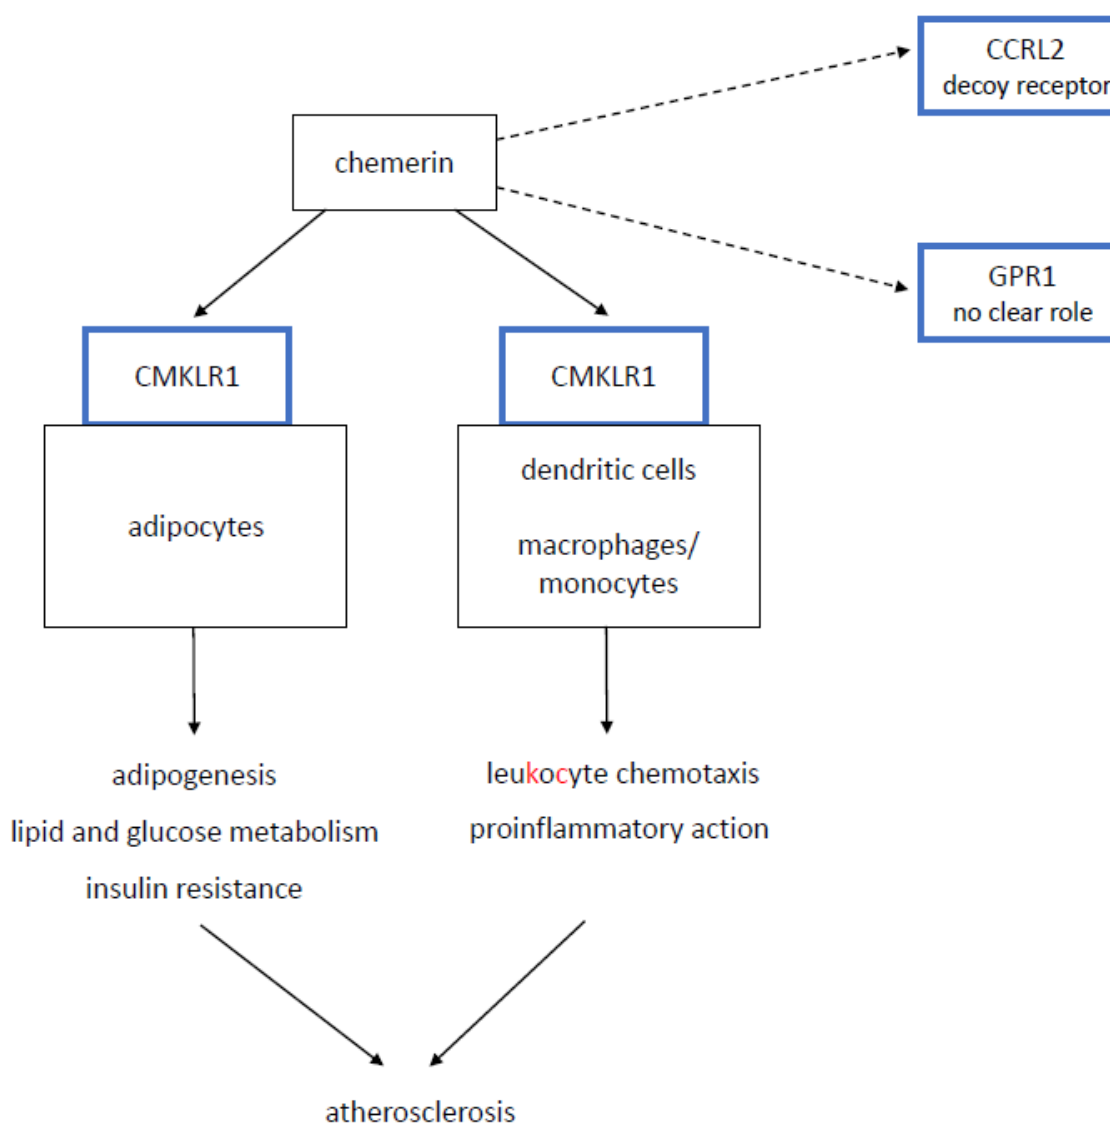
Figure 1. Basic patophysiological pathways of chemerin. CMKLR1—chemokine-like receptor 1; GPR1—G protein-coupled receptor 1; CCRL2—C-C motif receptor-like 2. Solid line—major pathways. Dotted line—minor pathways.